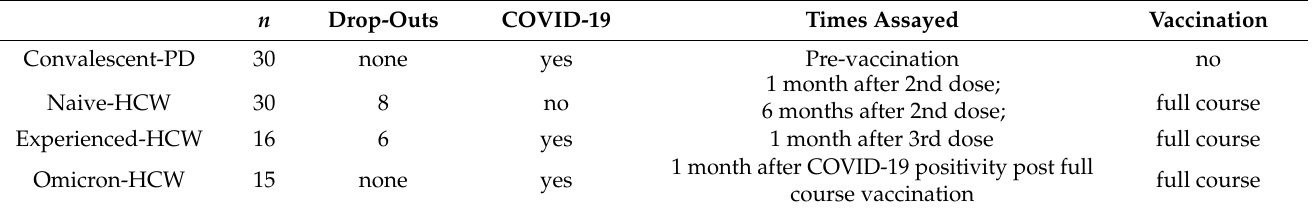
Table 1. Overview of the study populations. For the experienced-HCW and the Omicron-HCW populations all the available subjects were included, while the groups convalescent-PD and naïve- HCW were randomly selected from the pool of plasma donors and healthcare workers of Policlinico San Matteo,